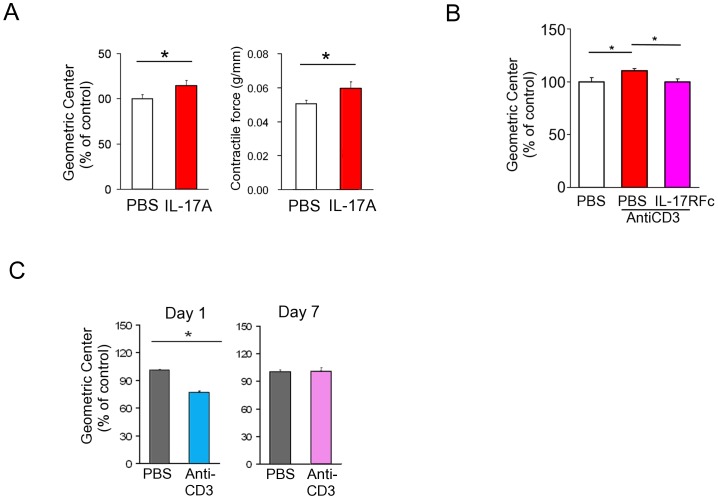
A possible involvement of IL-17A in αCD3-induced hypermotility.(A) Calculated GCs (left panel) and contractile response induced by 10−5 M CCh (right panel) of IL-17A-injected mice (n = 11∼15). Saline or IL-17A (10 µg/mouse/day) was intraperitoneally injected three times. GC was measured on day 5. SI strips was isolated on day 5 and the contractility was immediately measured. (B) Calculated GCs of αCD3-injected mice in the recovery phase. The effect of IL-17R-FcChimera (twice i.p. at 1.5 and 3 hrs after αCD3-injection; n = 13–15) was demonstrated. (C) Calculated GCs of control and αCD3-injected IL-17 KO mice in the day 1 inflammatory phase (n = 3) and in the day 7 recovery phase (n = 11∼13). Numerical data represent means ± s.e.m. *P<0.05 versus control/PBS-treated, Student's t-test (A-C) with Bonferroni correction for multiple comparison (B).